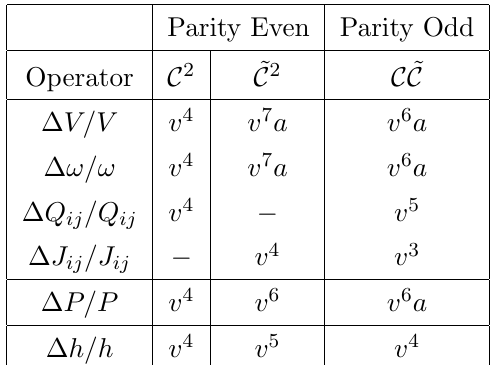
Table 1 . Summary of the relative contribution of the parity even and parity odd operators to vari- ous quantities in comparison to the leading contribution to the same quantity in General Relativity. Only the dependence on v and a , the spin parameter in the Kerr metric of the fastest spinning black hole, is shown (there is always, respectively, a factor of 1 = ((cid:3) r ) 6 , 1 = (~(cid:3) r ) 6 or 1 = ((cid:3) (cid:0) r ) 6 in each col- umn, left implicit). a is related to the spin vector of a black hole S i , as a = p S i S i = ( GM 2 ). The ‘ sign indicates that the contribution is subleading and was not